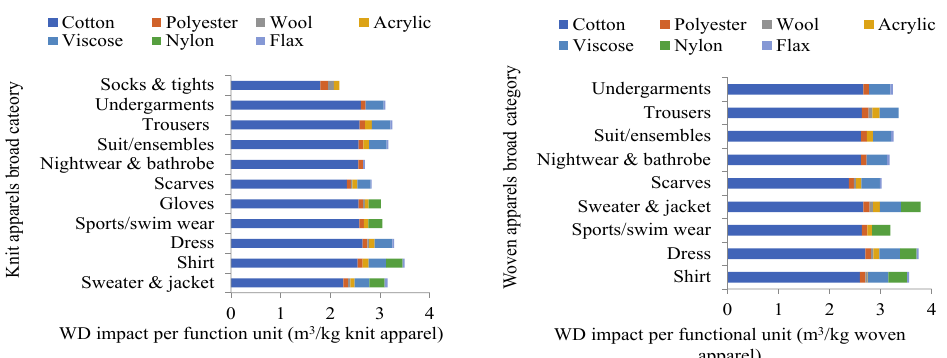
Fig. 6. WD impact (per kilo-gram apparel) of knit and woven apparel broad categories.